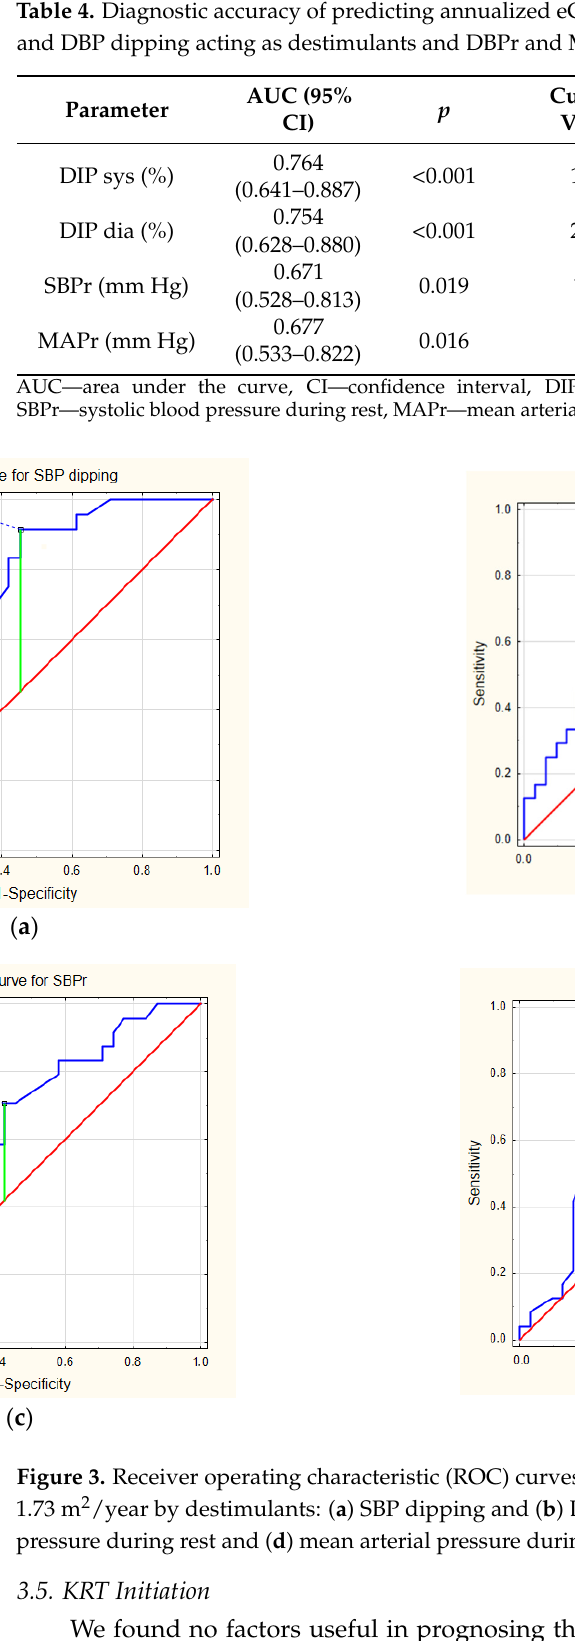
( b ) Figure 2. Kaplan–Meier estimator (F Cox test) for survival without CKD progression by ≥ 1 stage for children ( a ) with and without initially diagnosed arterial hypertension and ( b ) with and without initially present proteinuria.